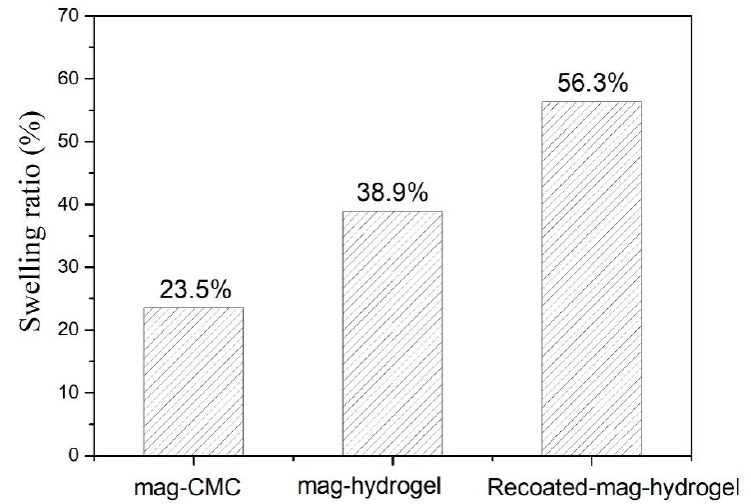
Figure 12. The equilibrium swelling ratio of magnetic nanocomposites (pH = 7, 25 °C).